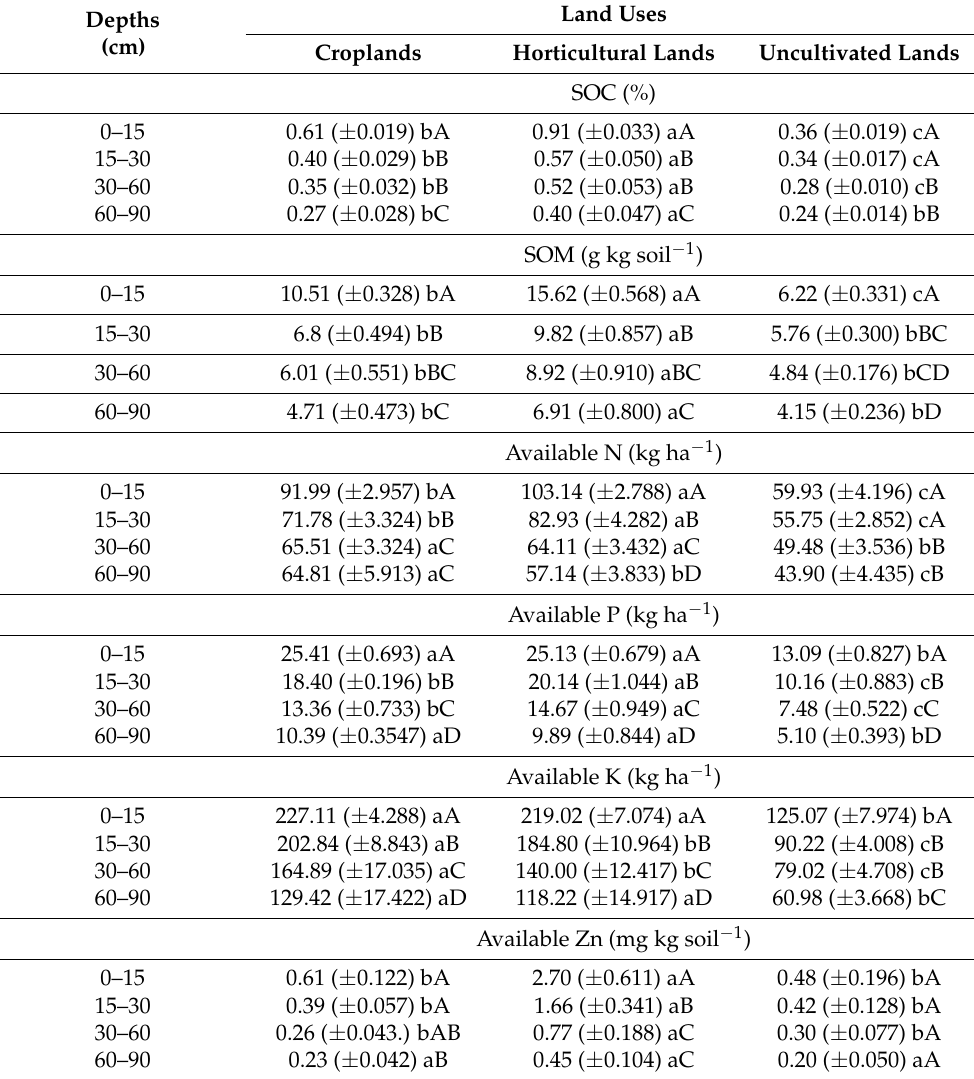
Table 4. Soil organic carbon (%), availability of N, P and K (kg ha − 1 ) and micronutrients (Fe, Mn, Zn and Cu) (mg kg − 1 ) are under-studied land uses in south-western Punjab, India. Land Uses Depths (cm) Croplands Horticultural